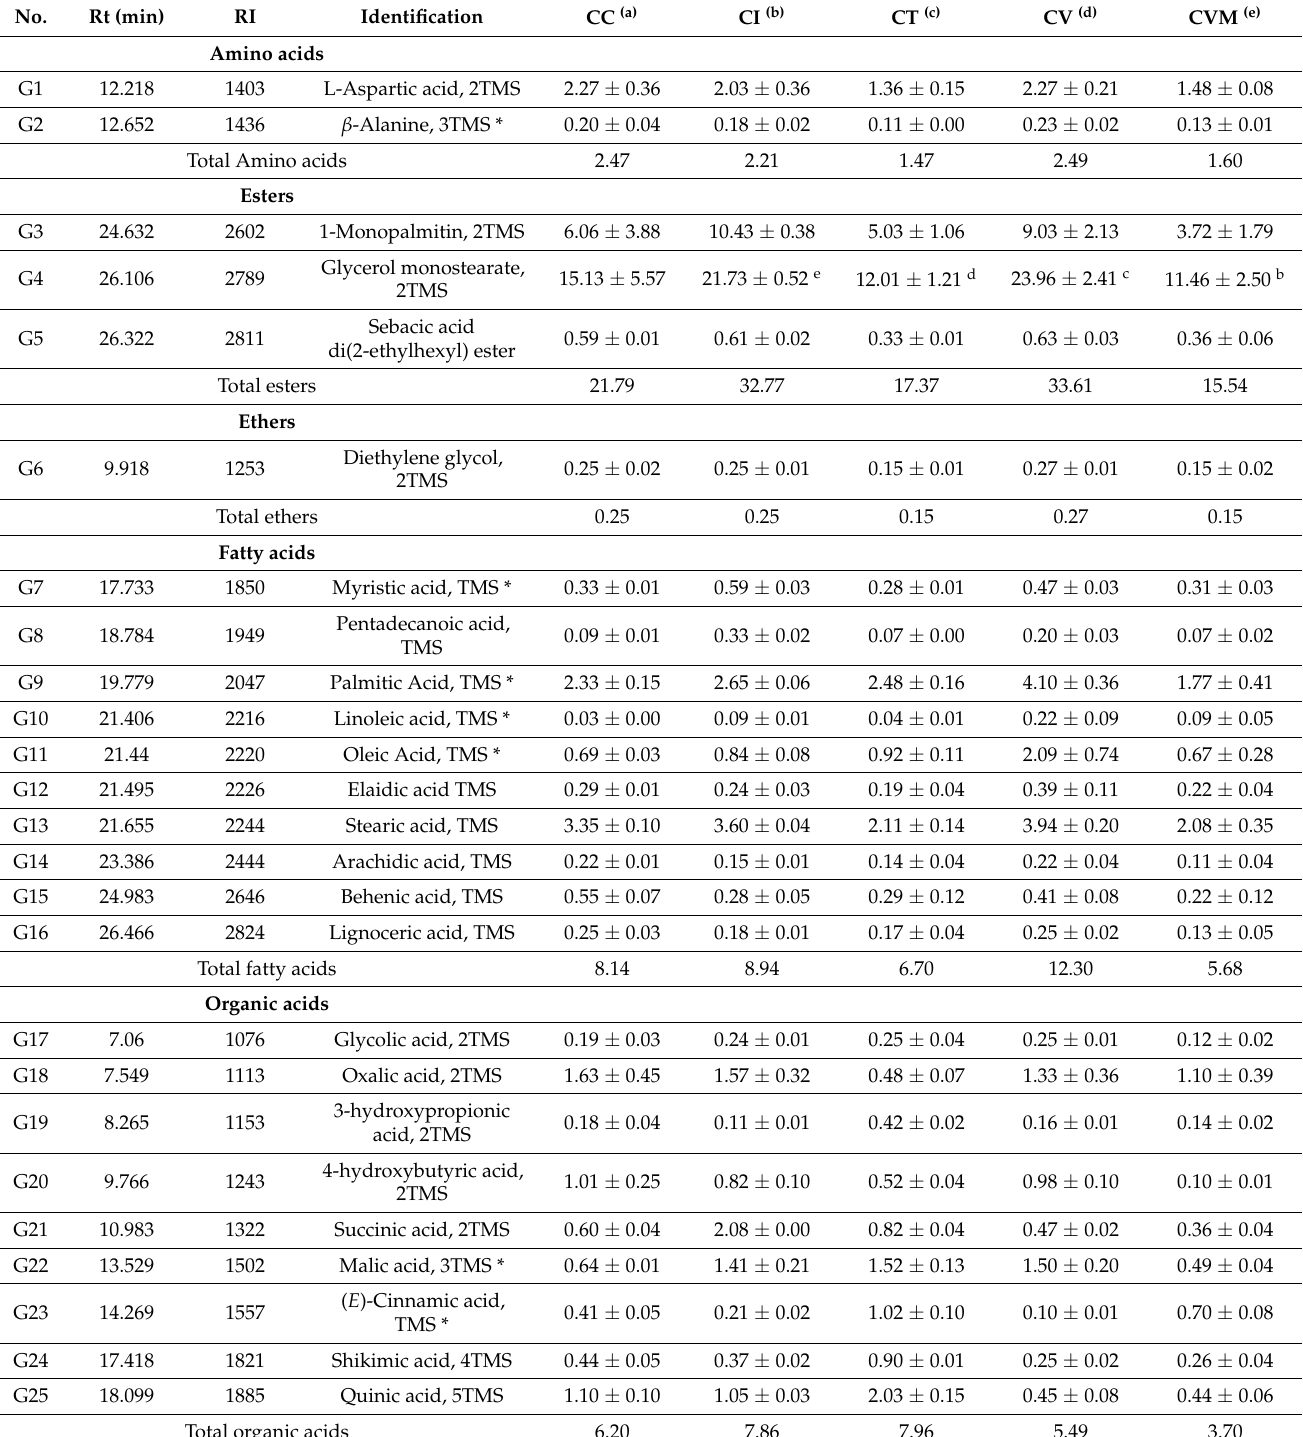
Table 2. Relative percentage of non-volatile metabolites detected in cinnamon barks using HS-SPME- GC-MS (peak numbers are preceded by G in text) measurements ( n = 3) represented as average ± standard errors. Different letters indicate significant differences between cinnamon accessions according to the least significant difference analysis ( p < 0.05; Tukey’s test). CC: Cinnamomum cassia from Malaysia, CI: C. iners from Malaysia, CT: C. tamala from Pakistan, CV: C. verum from Pakistan, CVM : C. verum from Malaysia. ( a )–( e ) significantly different form the corresponding group. * Compounds confirmed by standards